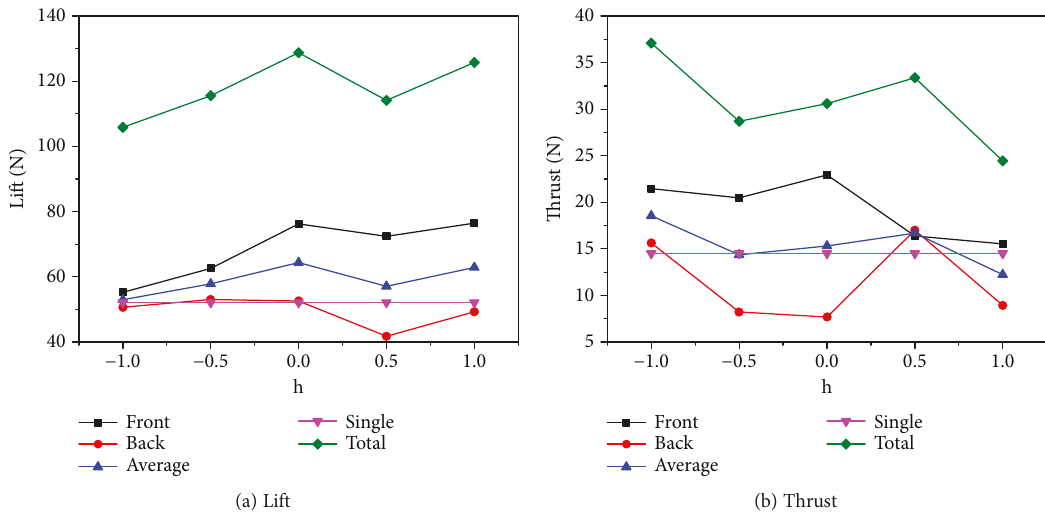
Figure 9: Tandem fan wing aerodynamic force with the changing curve following di ff erent heights between the front and rear wings.